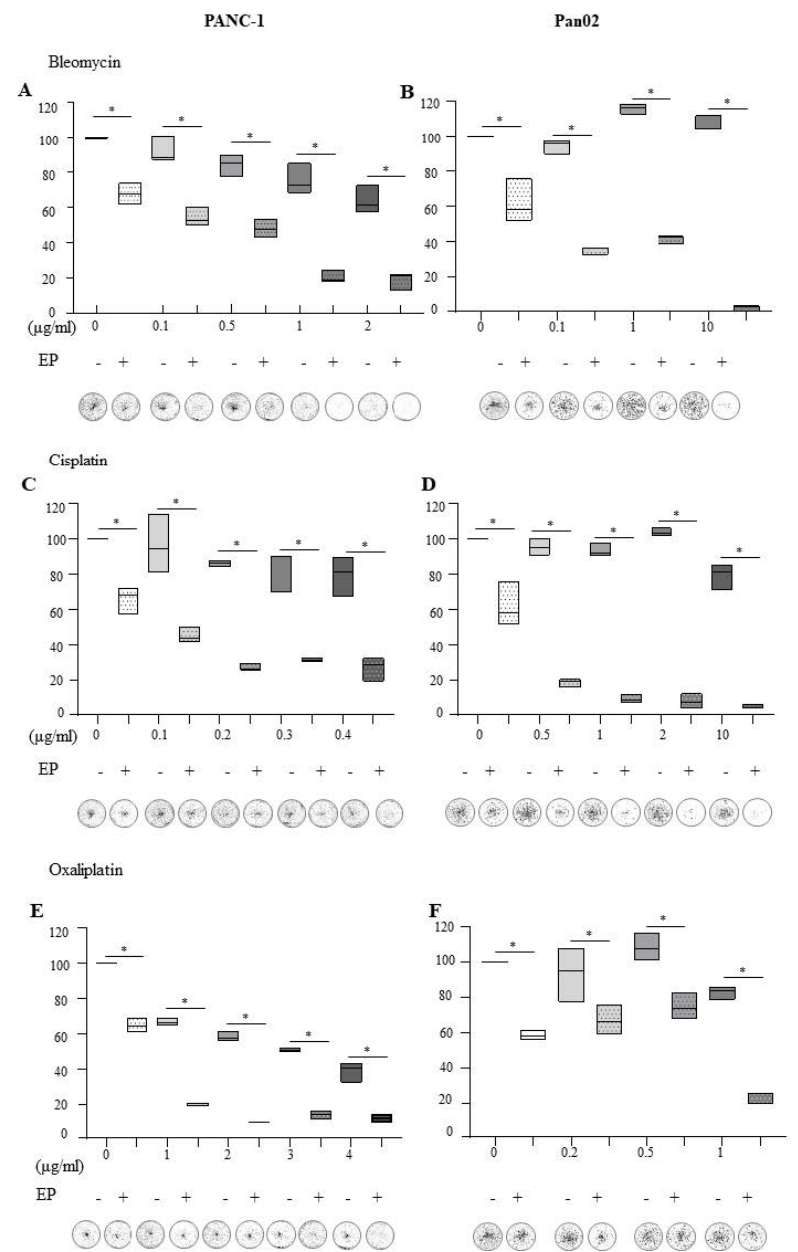
Figure 1. ECT negatively affects the ability of pancreatic cancer cells to recover relative to treatment with chemotherapy alone. (1 million cells were resuspended in EP buffer in the presence or absence of ( A , B , 0.1–10 μ g/mL Bleomycin), ( C , D , 0.1–10 μ g/mL Cisplatin), or ( E , F , 0.2–4 μ g/mL Oxaliplatin). Cells were electroporated and 24 h later, 1000 cells (PANC-1) or 400 cells (Pan02) were seeded in triplicate in complete media in six well plates. The recovery of cells post treatment was quantified by fluorescent intensities of colonies formed after 10–14 days. Each well is a representative of at least nine similar wells (three independent experiments). The data (minimum to maximum) is also presented as floating bar graphs—with the median integrated intensity relative to EP buffer alone denoted with a line. * statistically significant differences in the number of colonies formed when cells were allowed to recover, * p = 0.05.